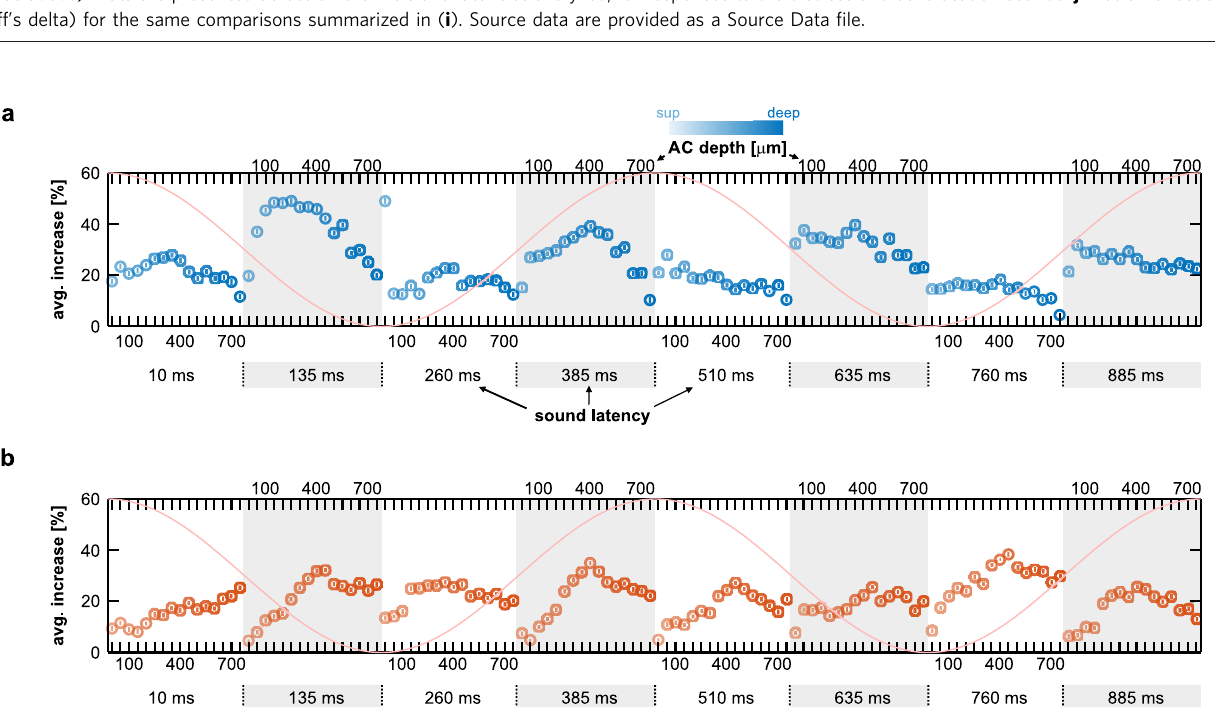
Fig. 5 Relative AC response increase after FAF electrical stimulation depends on sound-onset latency. a Average relative increase in response strength to the echolocation pulses during the Estim conditions relative to the no-Estim condition (expressed as percentage increase). Each circle corresponds to a channel in AC; note that all channels and sound latencies are shown (lighter colors correspond to electrodes located at lower depths). The center of the circle indicates the mean of the group ( n = 500 iterations), while vertical bars indicate the 95% con fi dence intervals. In the fi gure, values are signi fi cantly different if their con fi dence intervals do not overlap ( multcompare function in Matlab; alpha = 0.05, multiple comparisons corrected using Tukey – Kramer critical values). b Data related to responses to the distress syllable, shown as in ( a ). The purple cosine curve tracks the corresponding phase of the 2 Hz electrical stimulation (although note that electrical stimulation had stopped before sound onset; see also Fig. 4a). Data shown in this fi gure are the same used for Fig.